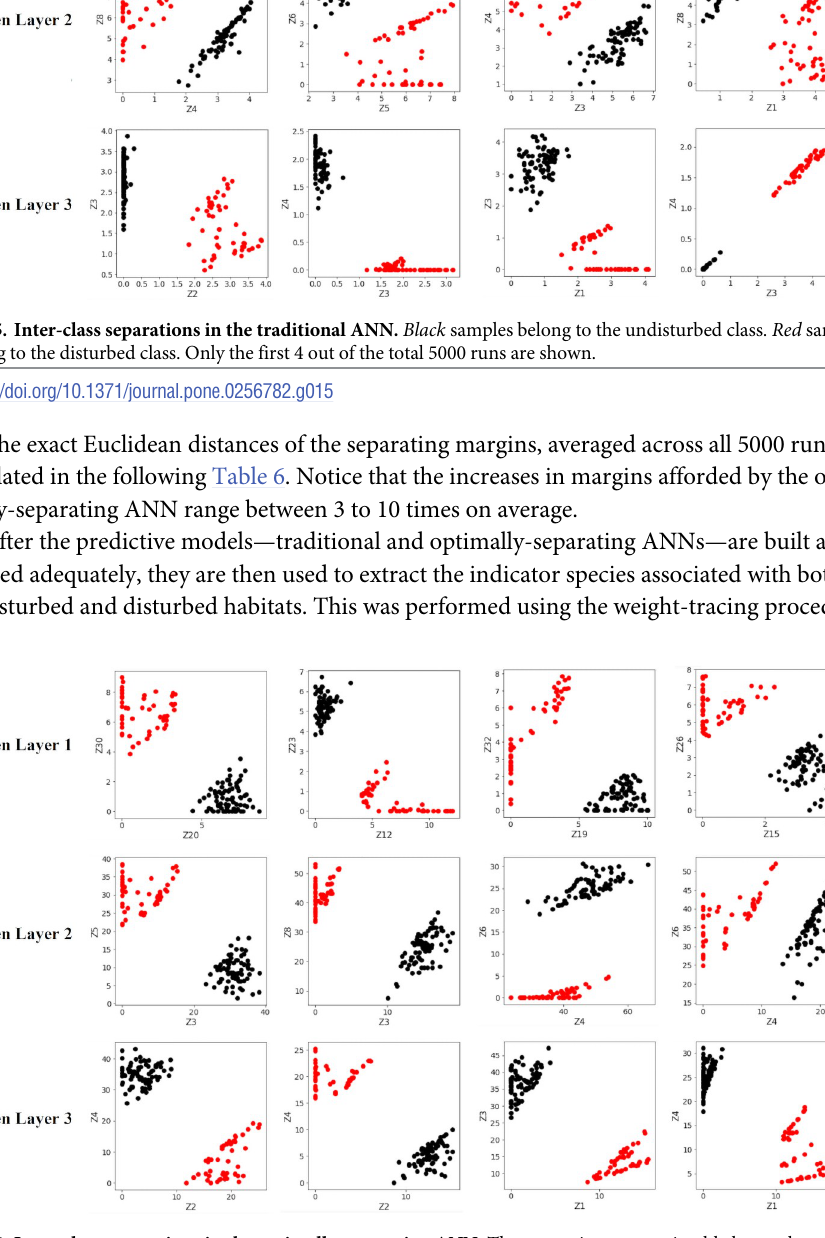
Fig 16. Inter-class separations in the optimally-separating ANN. The separations are noticeably larger than those in Fig 15. Black samples belong to the undisturbed class. Red samples belong to the disturbed class. Only the first 4 out of the total 5000 runs are